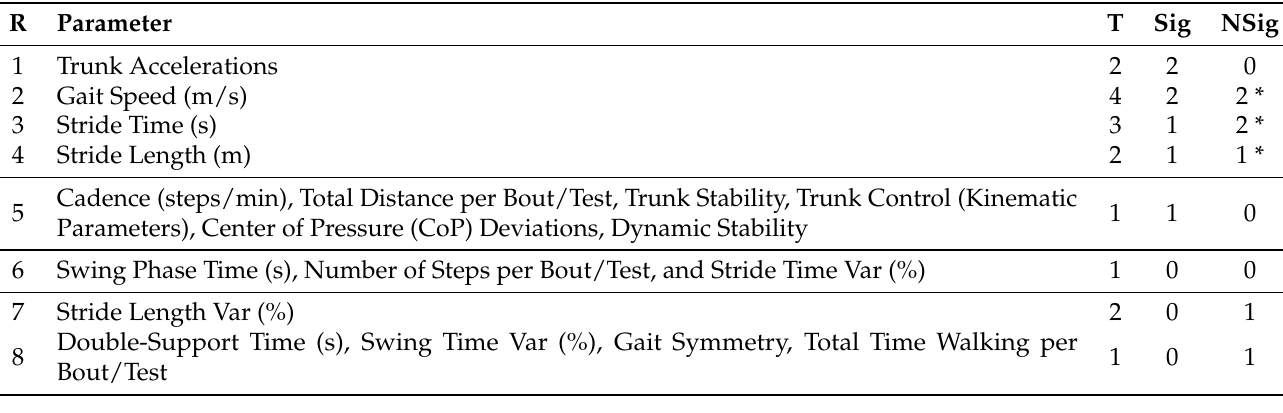
Table 8. Gait parameters related to fall risk sorted by importance (total times and significance). R: Ranking, T: number of total Times that each parameter is included, Sig: number of times that each parameter is considered “Significant”, and NSig: number of times that a parameter is considered as “Nonsignificant” among fall risk patients. Symbol “*” marks the